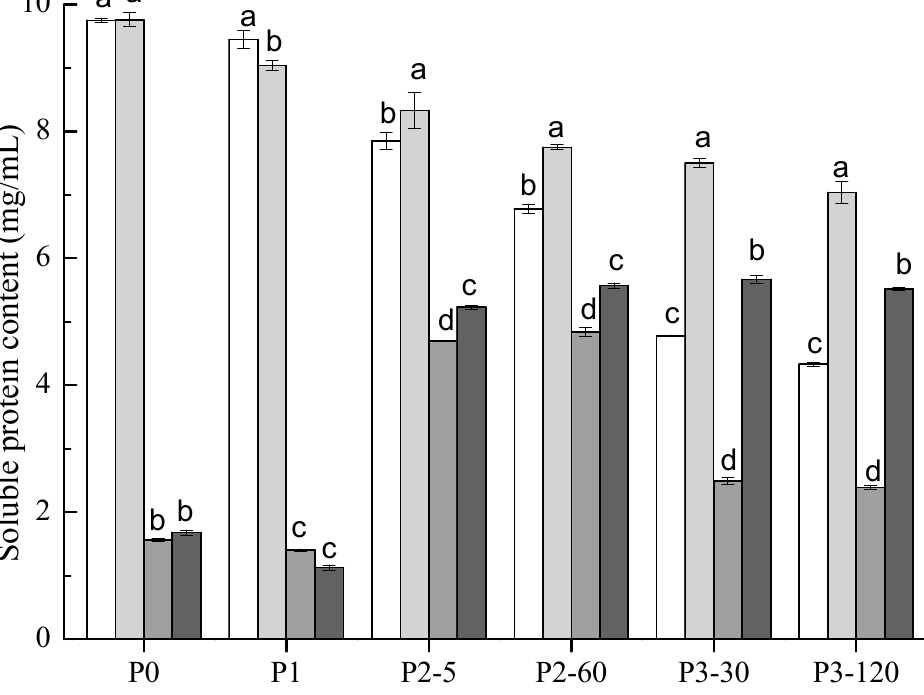
Figure 4. Soluble protein content (mg/mL) of soymilk (white), ST (light gray), SG (gray) and STG (black) samples at different phases of in vitro GIS. Within the same digestive phase, different lowercase letters indicate a significant difference ( p < 0.05).